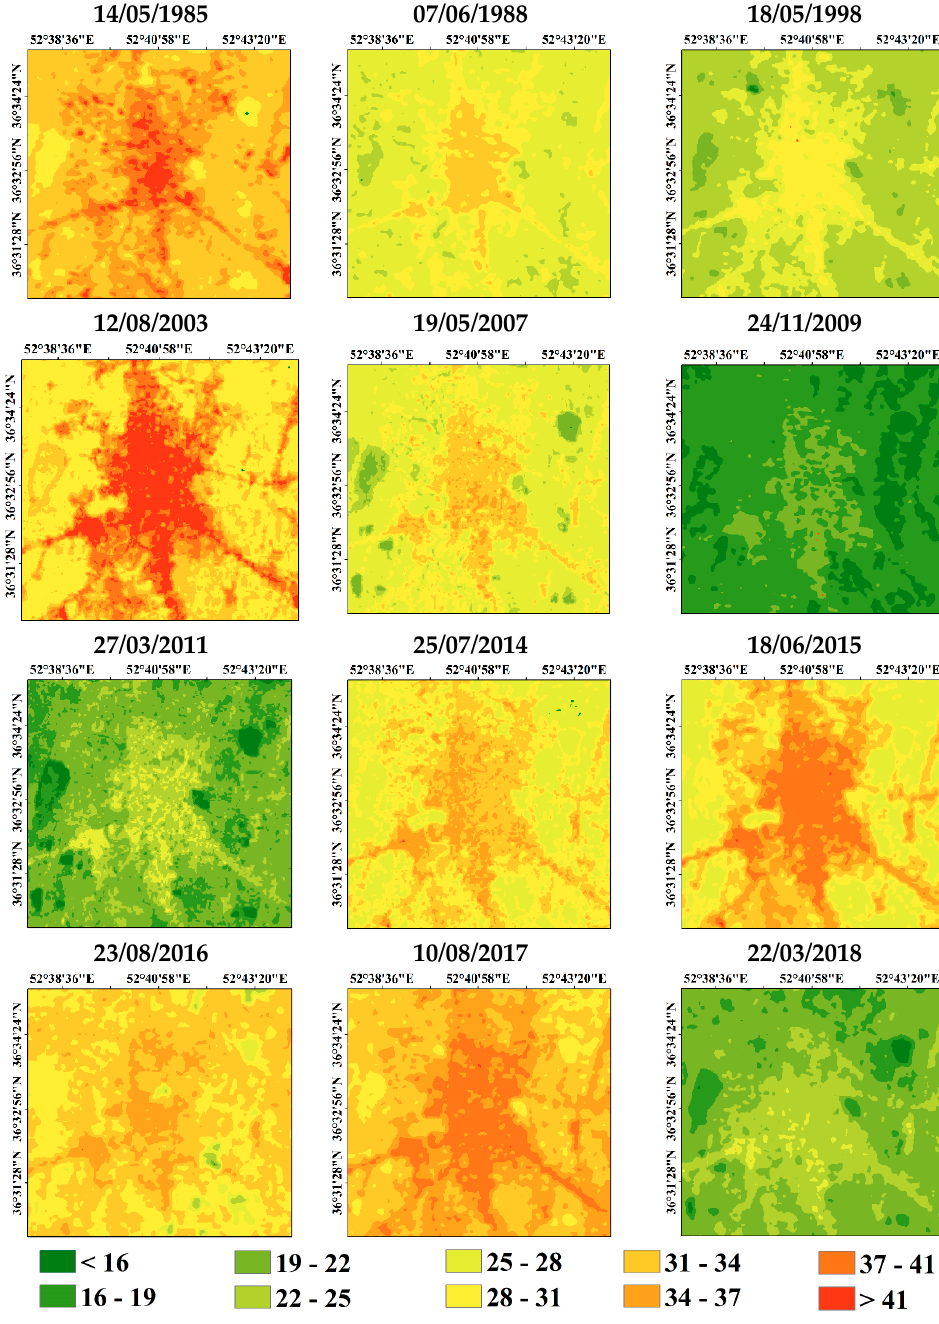
Figure 5. Examples of land surface temperature (LST) maps (°C) for the time period of 1985–2018 in Babol City, Iran.